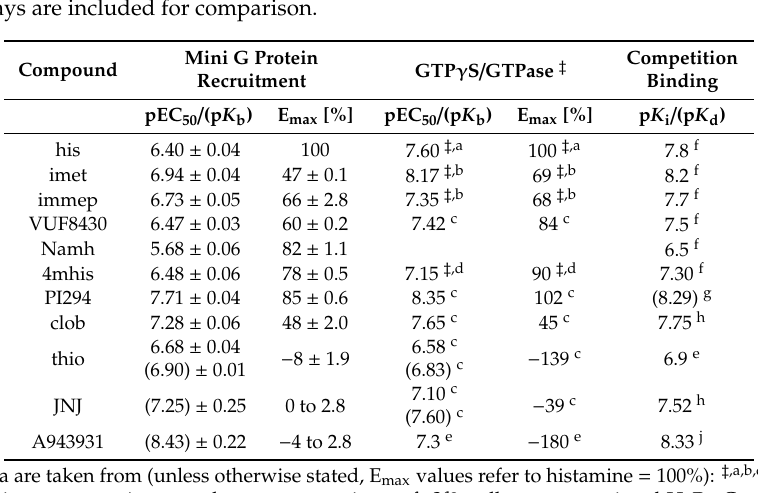
Table 4. Potencies (pEC 50 / p K b ) and e ffi cacies (E max ) of ligands at the H 4 R explored in the mini-G protein recruitment assay. Data represent mean values ± SEM of at least three independent experiments ( n ≥ 3) each performed in triplicate. Functional data obtained in proximal [ 35 S]GTP γ S and steady-state GTPase and ligand binding a ffi nities (p K i , p K d ) determined in radioligand competition / saturation binding assays are included for